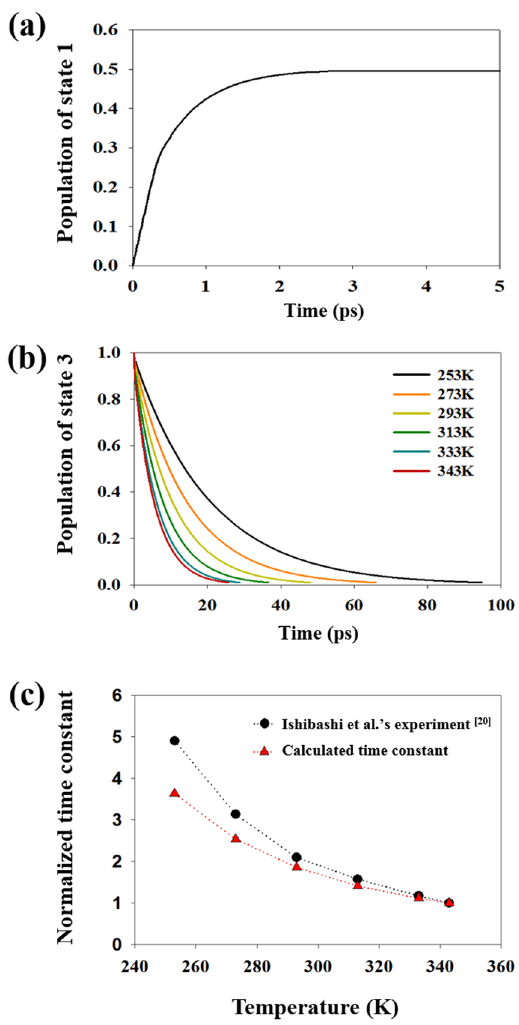
Figure 4. ( a ) Population of the ground state of the closed ring isomer under UV pulse laser irradiation (cyclization). ( b ) Population of the first excited state of the closed ring isomer according to the temperature under vis pulse laser irradiation (cycloreversion). ( c ) Temperature dependency of time constants of calculated population under vis pulse laser irradiation. The constants of our model and Ishibashi et al . 23 are normalized by each value at 343